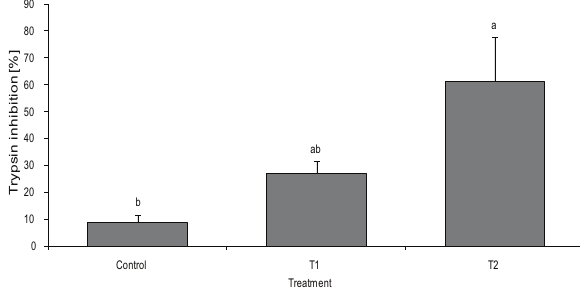
Fig. 5. Plasma natural haemolytic complement activity (ACH50) of tinfoil barb, Barbonymus schwanenfeldii , fed different levels of dietary probiotics (control, 0 CFU · g –1 diet; T1, 1 × 10 4 CFU · g –1 diet; T2, 1 × 10 6 CFU · g –1 diet) for 15 days; Data are presented as mean ± SE ( n = 9); No significant difference ( P > 0.05) was observed between